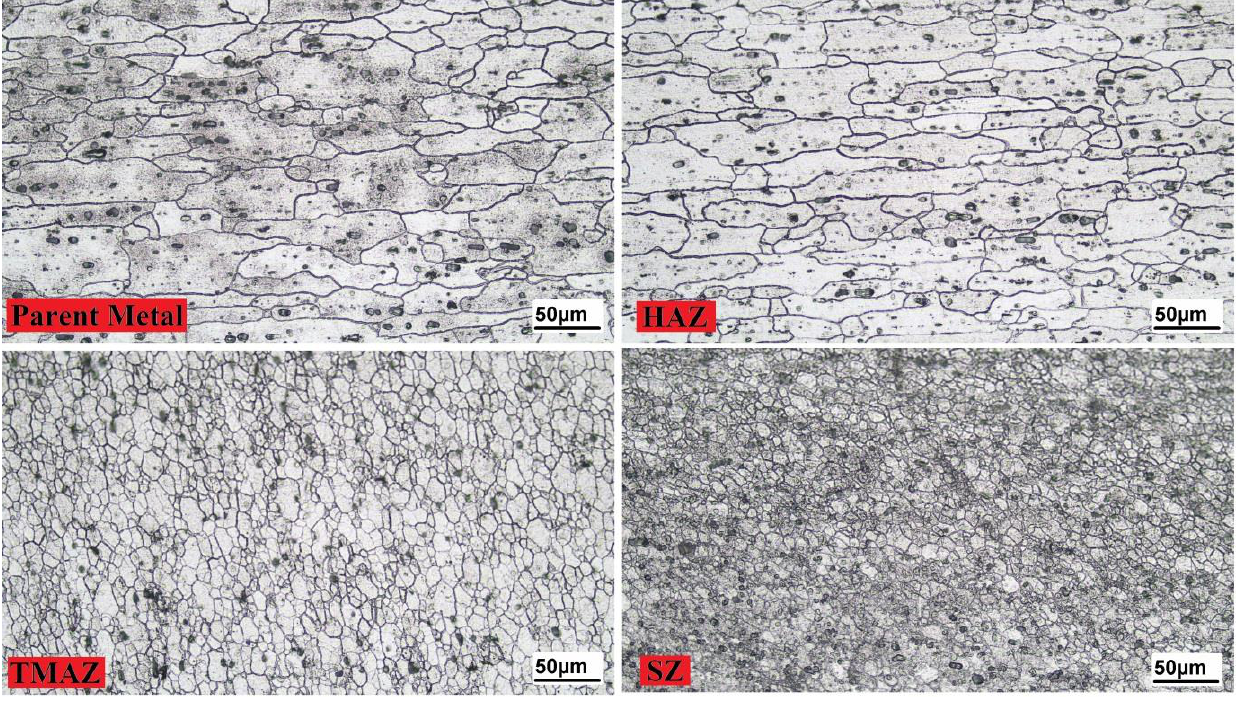
Figure 13. Microstructure of different areas of the sample welded by FSW technique. In all samples, the lowest hardness values occurred in the HAZ. After the HAZ re- gion, TMAZ and SZ had the least amount of hardness. In the SZ, due to the presence of large plastic flow and heat close to the melting temperature, complete dynamic recrystal- lization, and more appropriate microstructure modification are formed in this region. Due